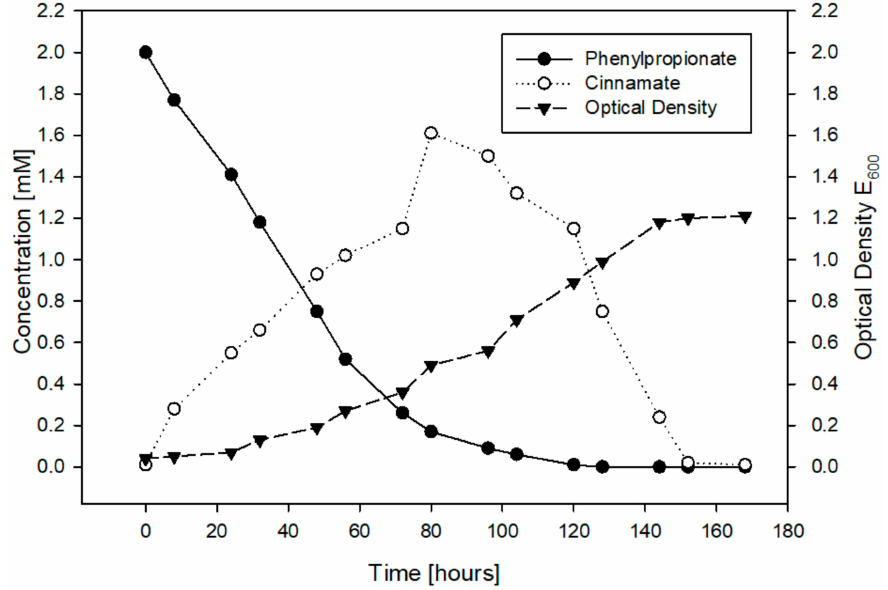
Figure 1. Growth of Sphingopyxis granuli RW412 as indicated by the depletion of 3PPA (solid circles) over time and the increase in biomass (solid triangles), as determined by measuring the Optical Density (E 600 ) of the culture. The accumulation and depletion of (later-on identified) cinnamate is indicated with open circles.